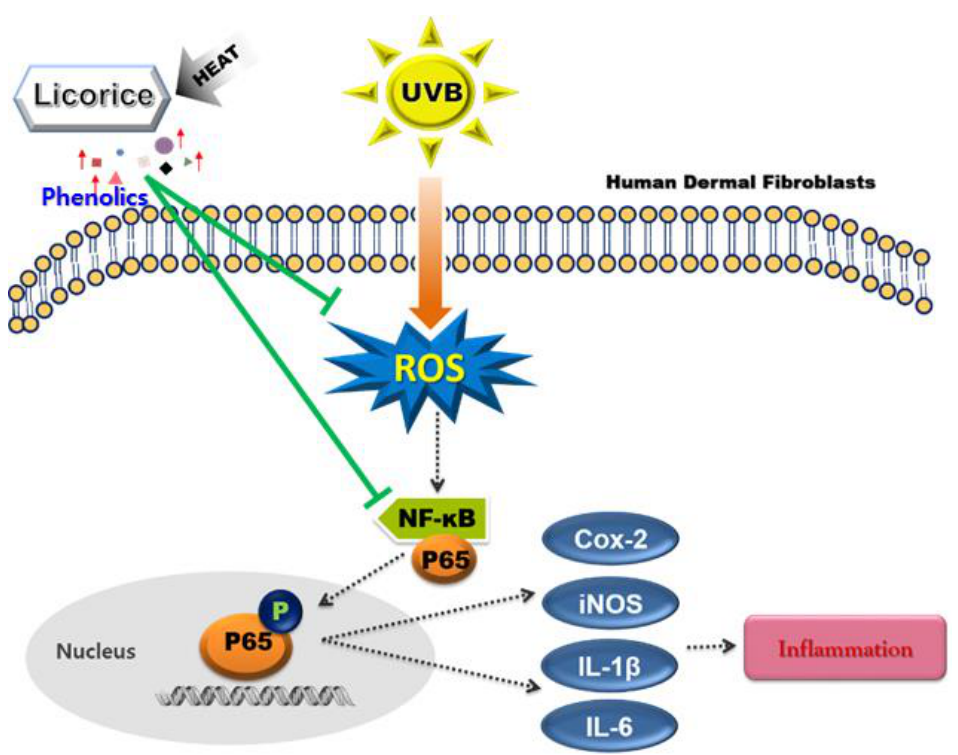
Figure 6. Schematic diagram of the UV photoprotective effects of licorice on HDFs. The green line and arrows indicate inhibition and stimulation, respectively. This schematic shows the potential protective effect of the HL extract against UVB-induced skin